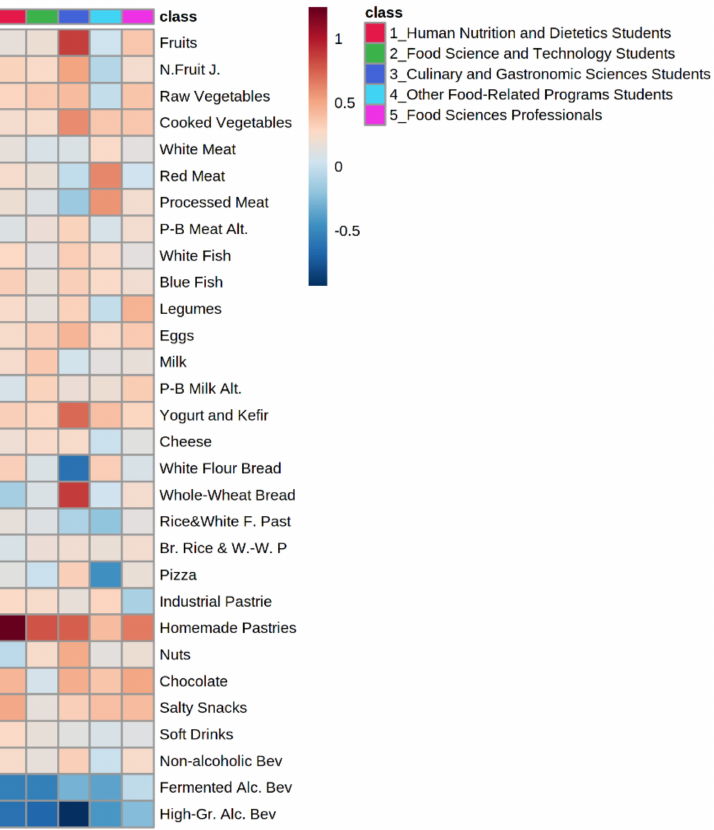
Figure 2. Heatmap visualization showed the magnitude of the variation (increase or decrease) in the intake of each foodstuff during COVID-19 lockdown considering the different collectives 1 of the study sample. Blue color scale indicates a decrease in consumption and red color scale corresponds to an increase in consumption. 1 Number and percentage of individuals by collective ( n , %): Human Nutrition and Dietetics Students (122, 38%), Food Science and Technology Students (64, 20%), Culinary and Gastronomic Sciences Students (33, 10%), Other Food-Related Programs Students (18, 6%), Food Sciences Professionals (84,